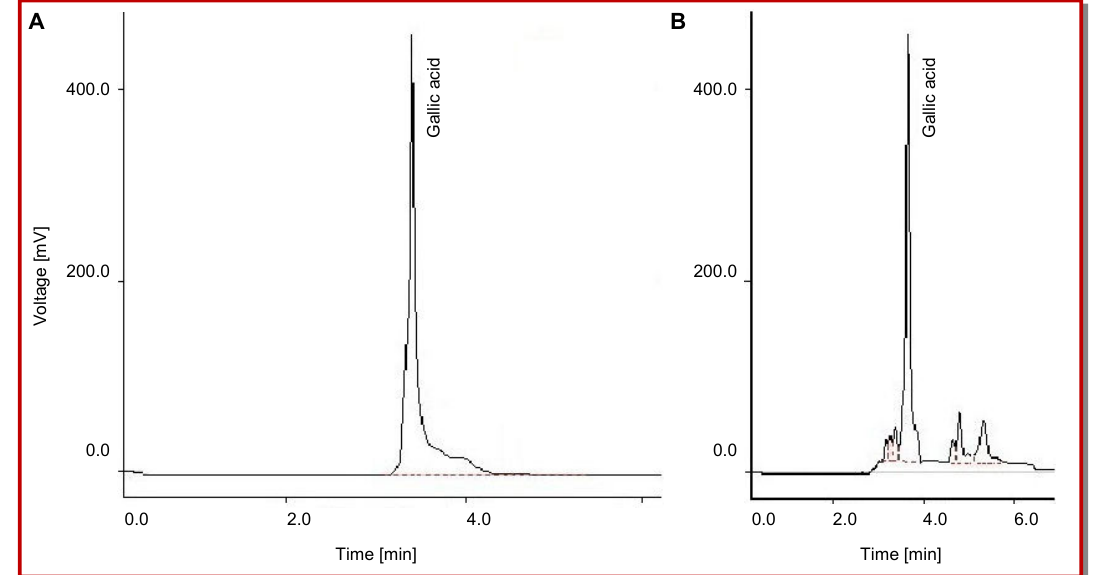
Figure 1: HPLC chromatogram of an authenticate standard gallic acid (A), and gallic acid identified in ethanol extract of D. mala- barica extract at a dose of 400 mg/kg had shown more signi- ficant effect when compared to the standard drug